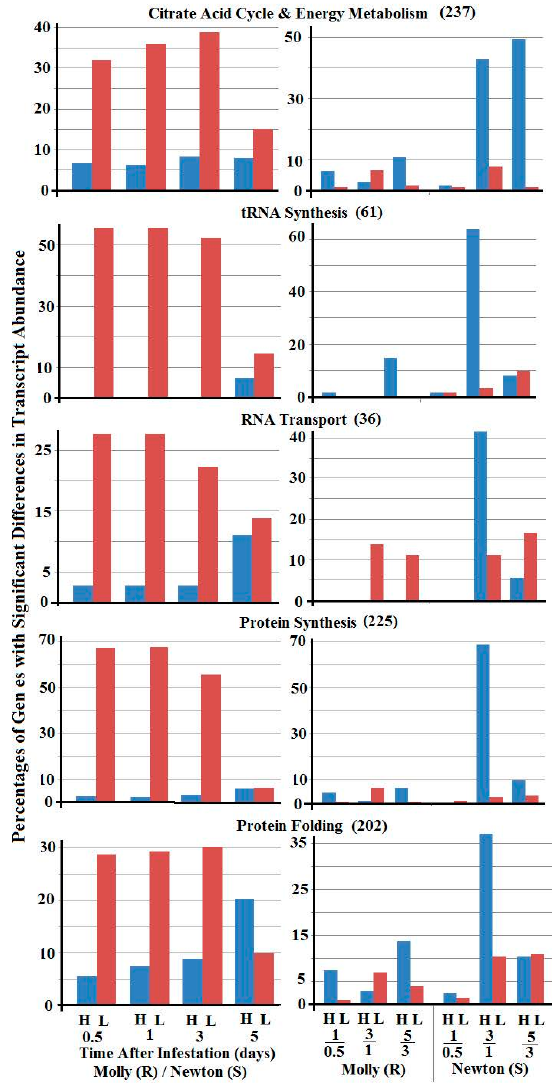
Figure 3. Percentages of genes in selected subcategories with higher (blue bars, H) and lower (red bars, L) transcript abundance between larvae feeding in resistant (Molly) and susceptible (Newton) plants at 0.5, 1, 3, and 5 days ( left panels), and between two successive stages (1 versus 0.5 day, 3 versus 1 day, and 5 versus 3 days) of Hessian fly larvae feeding in either resistant (Molly) or susceptible (Newton) plants ( right panels). Gene subcategories are marked on each pair of graphs. The numbers of genes in each subcategory were given in parenthesis.